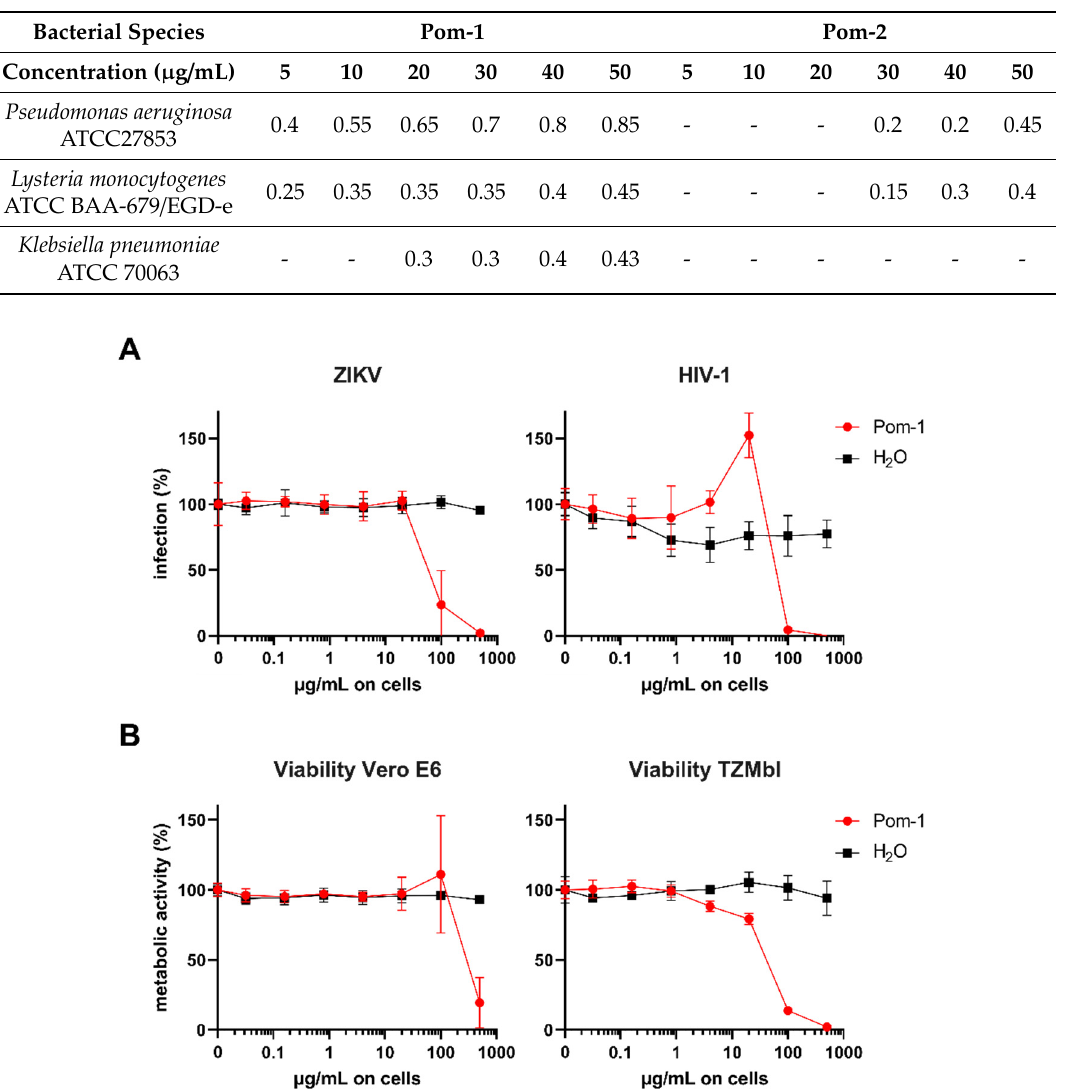
Figure 4. E ff ect of Pom-1 on Zika virus (ZIKV) and Human immunodeficiency virus 1 (HIV-1) Figure 4. Effect of Pom-1 on Zika virus (ZIKV) and Human immunodeficiency virus 1 (HIV-1)